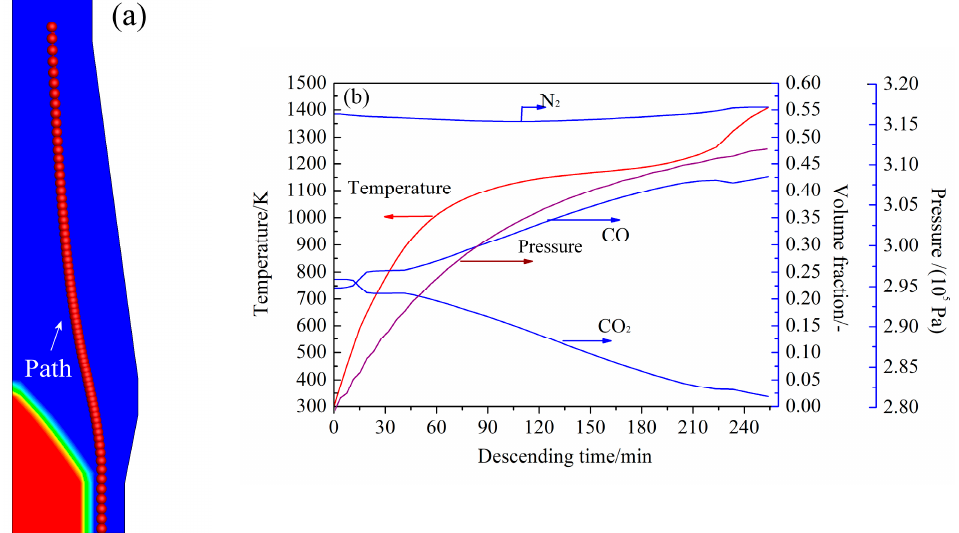
Figure 8. ( a ) Illustration of the CCB flowing path in the BF. ( b ) Change of the BF variables along the flowing path.